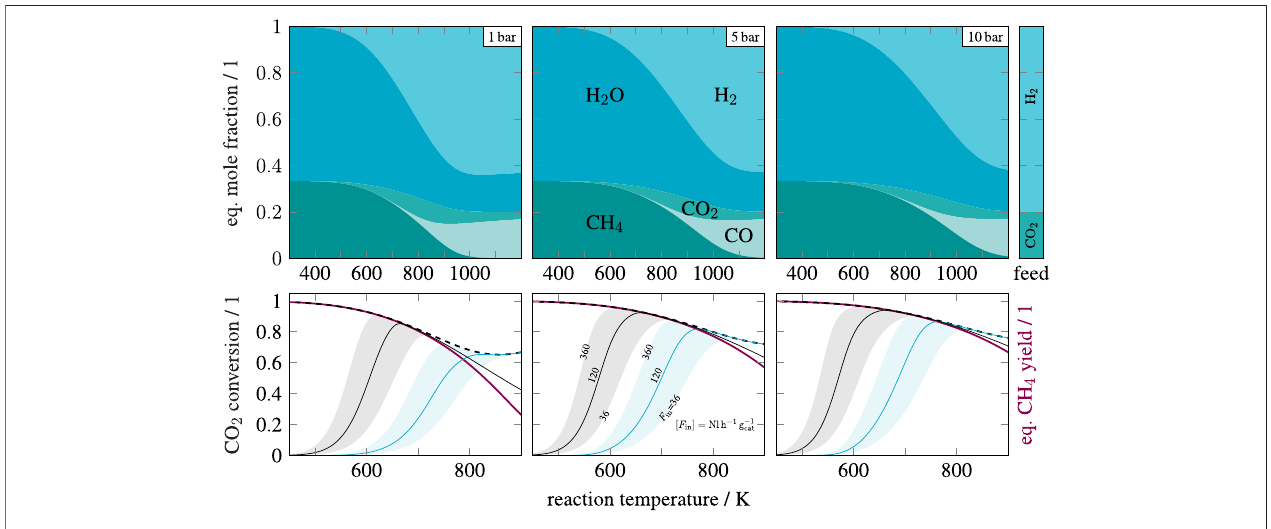
FIGURE 1 | Mole fractions at chemical equilibrium (top row) and kinetic conversion (bottom row) over temperature for pure, stoichiometric feed (H 2 / CO 2 (cid:2) 4) at ——— different pressures and fl ows, computed via Gibbs-free-energy minimization, kinetic model according to Koschany et al. (2016) ( —— ) and Xu and Froment (1989) ( —— ), equilibrium CO 2 conversion ( ⁃ ⁃ ⁃ ⁃ ⁃ ), equilibrium CH 4 yield (